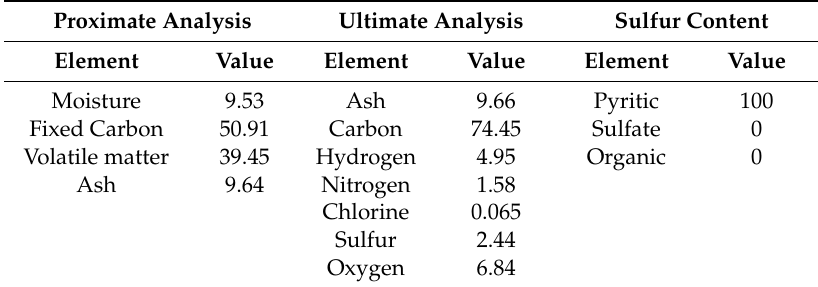
Table 1. Composition of coal used in the study.